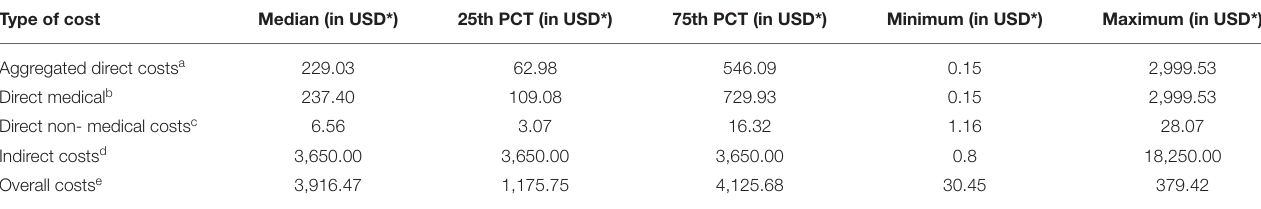
TABLE 5 | Cost of care of community-based patients with